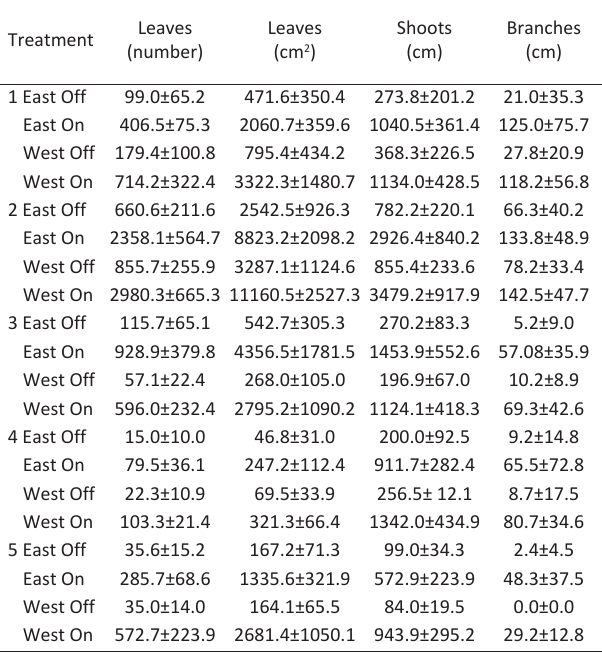
Samples 1, 3 and 5 refer to the same cv. Arbequina. Sample 2 to the cv. Tosca, sample 4 to the cv.